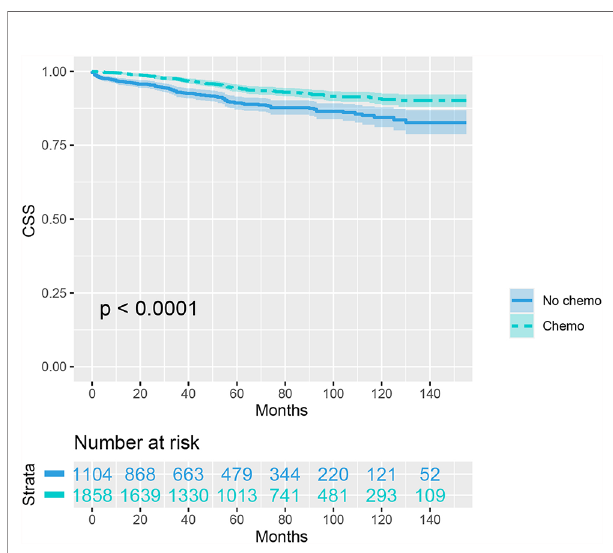
FIGURE 1 | Kaplan-Meier plot, revealing cancer-speci fi c survival differences based on the receipt of adjuvant chemotherapy in T1N+ colon cancer patients before propensity score matching.